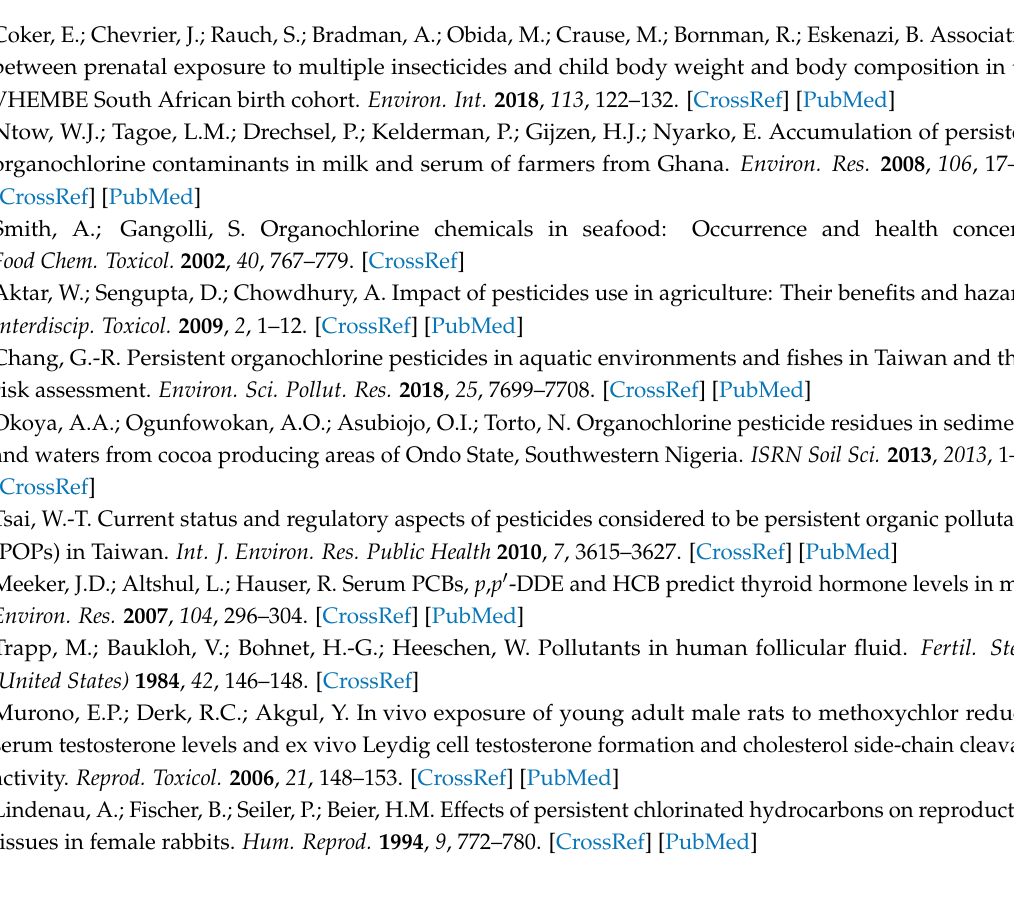
milk and their correlation to pork consumption as determined by logistic regression models, Table S14: Odds ratios of OCP residues in breast milk and their correlation to chicken consumption as determined by logistic regression models, Table S15: Odds ratios of OCP residues in breast milk and their associations to mothers who menarche before 13 years old in comparison to mothers who menarche after 13 years old as determined by logistic regression models, Table S16: Odds ratio of average periods of menstrual cycles of 27 to 29 days as compared to menstrual cycles of ≤ 26 and ≥ 30 days as determined by logistic regression models, Table S17: Odds ratio of breast milk OCP residues and their associations to women with average menstrual period days of >5 days as determined by logistic regression models, Table S18: Odds ratio of breast milk OCP residues and their associations to women with the shortest menstrual period days of ≤ 3 days as determined by logistic regression models, Table S19: Odds ratio of breast milk OCP residues and their associations to women who have taken contraceptives as determined by logistic regression models, Table S20: Odds ratio of breast milk OCP residues and their associations to women who have or have not taken hormonal drugs as determined by logistic regression models, Table S21: Odds ratios of OCP residues in breast milk from mothers who received infertility medical treatment in comparison to normal mothers as determined by logistic regression models, Table S22: Odds ratios of breast milk OCP residues in the participants having undergone gynecological surgery compared with those in normal women as determined by logistic regression models, Table S23: Sociodemographic characteristics, dietary habits and menstruation characteristics of mothers in association with OCP residues in breast milk as determined using the logistic regression model, Supplemental text: Limitation of small sample